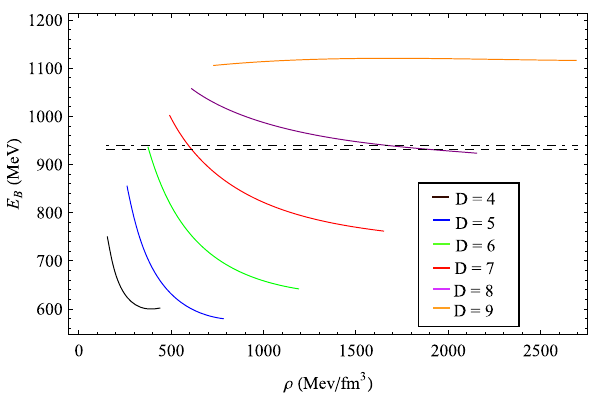
Fig. 17 Variationofenergyperbaryon( E B )withdensity( ρ )forPSRJ 1614-2230. Here the dashed line represents energy per baryon of 56 Fe which is 930.4 MeV and dot dashed line corresponds to the mass of nucleons (939 MeV)